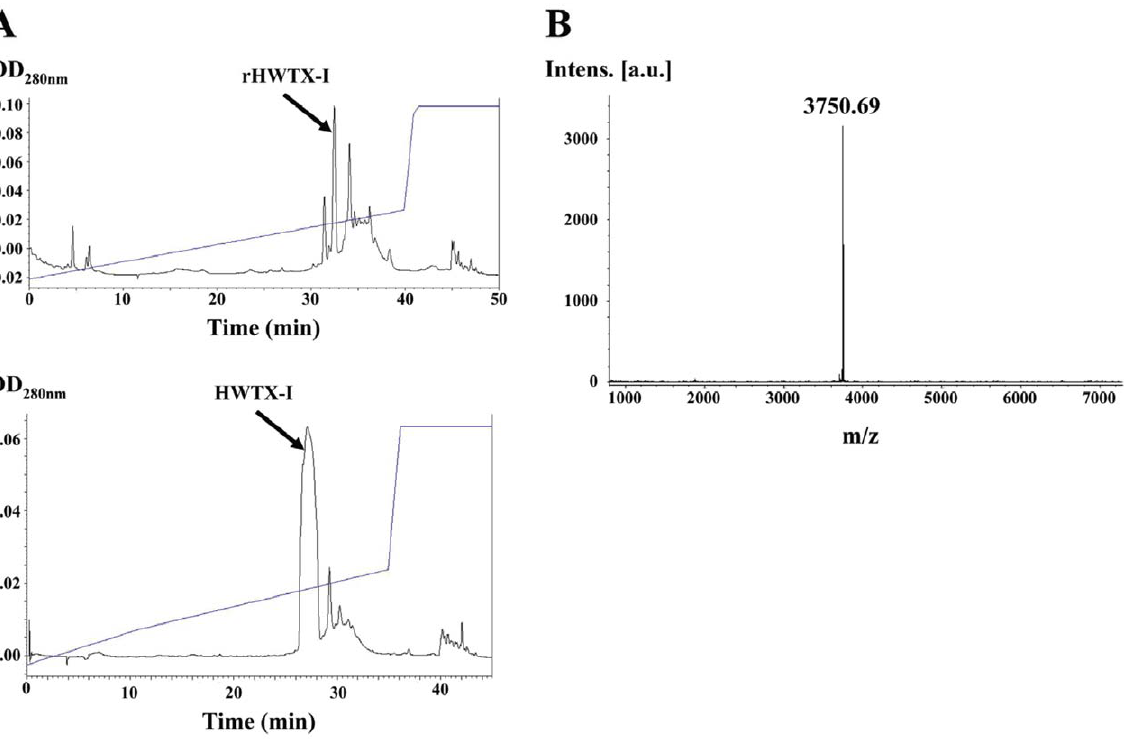
Figure 4. RP-HPLC chromatography and mass spectra of rHWTX-I. A) RP-HPLC chromatography of rHWTX-I (upper) and native HWTX-I (lower) in the same C18 column. Elution was monitored at 280 nm. rHWTX-I and native HWTX-I were eluted at an acetonitrile concentration of 30.4% and 30.6%, respectively. B) Mass spectra of purified rHWTX-I. The calculated theoretical molecular weight of rHWTX-I was 3756.45 Da and the measured molecular weight was 3750.69